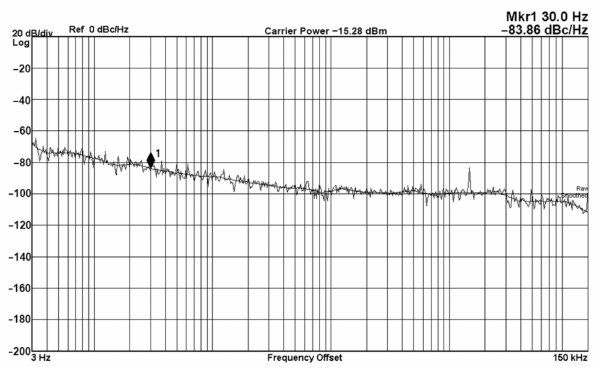
Figure 19. The measured phase noise performance of the NBPF at V BP2